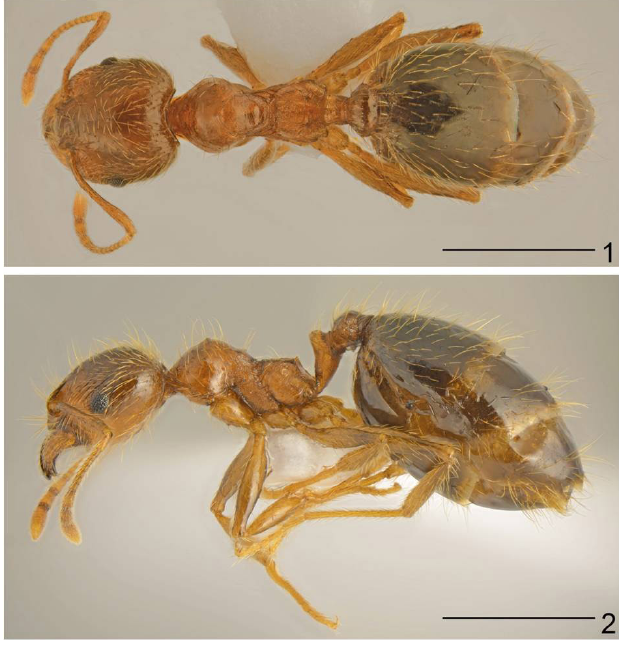
Figs 1-2 : Pale worker of teratological form “ symbiotica ” of Pheidole pallidula . 1. Dorsal; 2. Lateral. Scale bar = 1 mm. striation, space between punctures shiny. Masticatory margin mostly straight, with large apical and slightly smaller preapical tooth, small tooth in the middle and two small teeth basally. Anterior margin of clypeus straight or shallowly emarginate, surface shiny, without striation or ridges, on sides with few fine, setose punctures, basal clypeal lobe triangular, deeply impressed, sharply bordered from triangular frontal lobes. Frons bicornute anterad, triangular anterior lobes with fine longitudinal striation, frontal lateral margins sharp, short, extending to 1/3 length of head, central part of frons shiny,